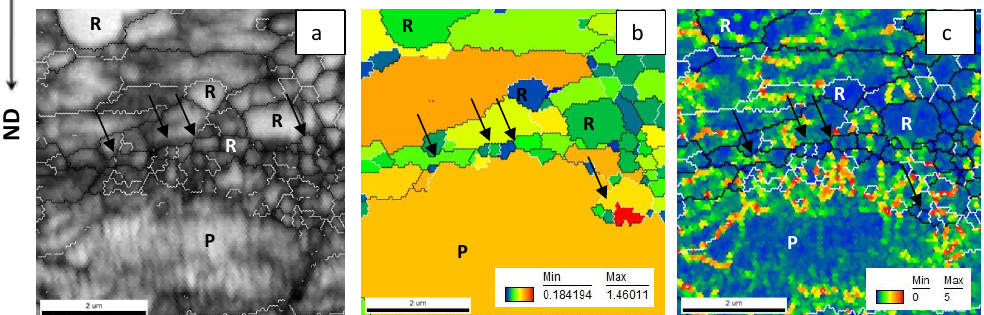
Figure 6. ( a ) Gray scale IQ map; ( b ) GAM map; and ( c ) KAM map (1st neighbor 5° max) for the sample heated at 150 °C/s to 704 °C and quenched. Letters in arrows are P for pearlite; and R for recrystallized ferrite. Grain boundary misorientation between 5° and 15° are outlined in white, whereas grain boundary misorientation between 15° and 63° are black. Step size 80 nm.